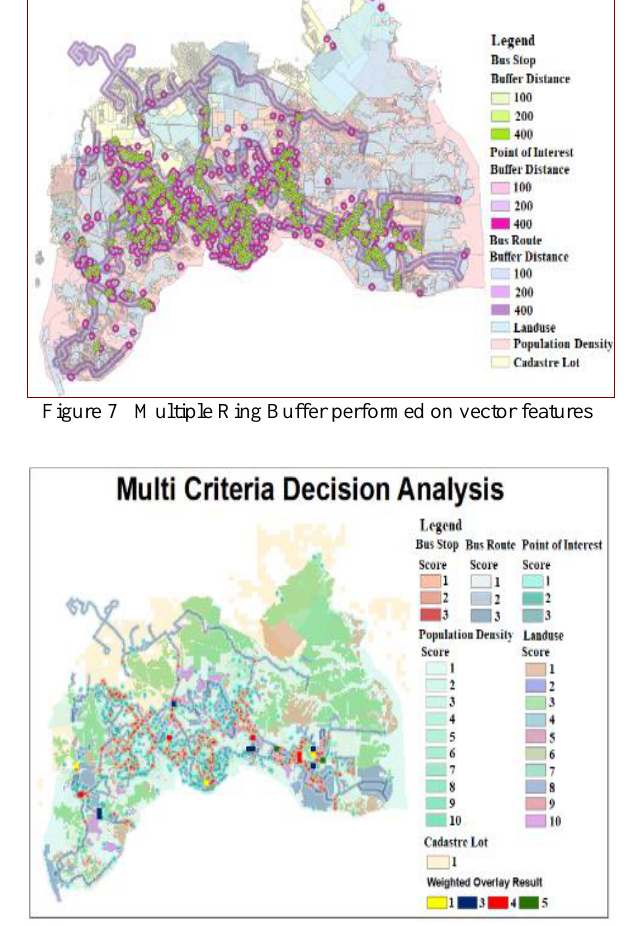
Figure 8 Reclassified Data based on Ranking